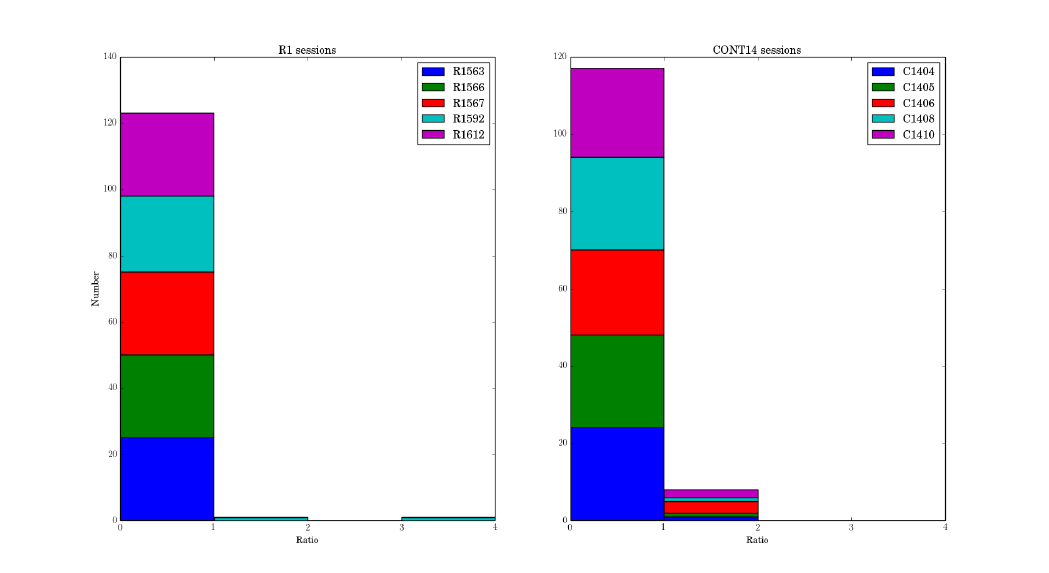
absolute ZWD differences between On and Od and their corresponding formal errors. The histograms show that most of the ZWD differences are within one standard de- viation from